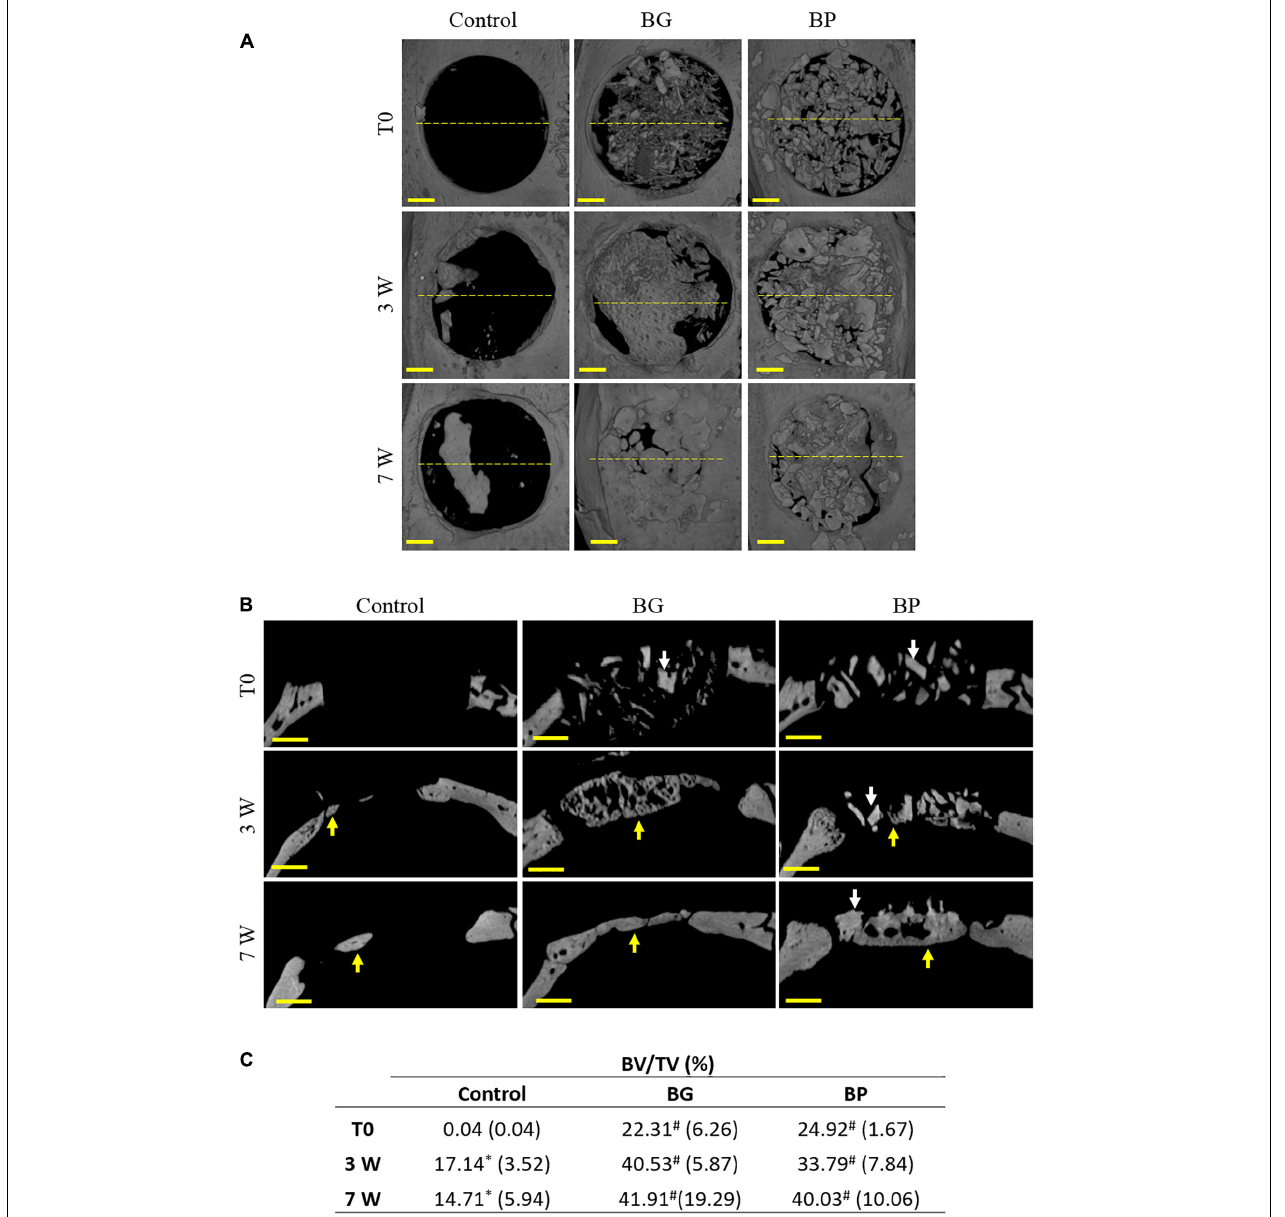
FIGURE 2 | Radiological observations and tridimensional quantifications of bone healing in critical-size defects in rat calvaria. Representative images of the 3D reconstruction of the defects at various times after the surgery (immediately after surgery (T0), 3 weeks (3 W), and 7 weeks (7 W) after surgery). The defects were left unfilled (control), filled with a syngeneic bone graft (BG), or filled with the bone paste (BP). (A) Top views and (B) coronal sections are shown. The yellow dashed lines indicate the coronal sections. Arrows indicate the grafted particles (white) or the newly formed bone (yellow). Scale bars: 1 mm. (C) Tridimensional quantifications of the bone volume (BV) relative to the tissue volume (TV) in the defects. ∗ p < 0.05 vs. T0 (columns), # p < 0.05 vs. Control (rows) (ANOVA with Bonferroni’s post hoc